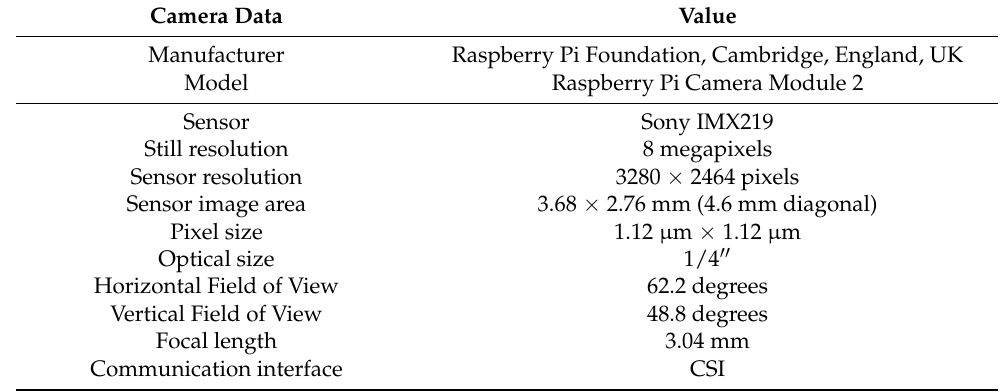
Table 2. Table of camera specifications [24].